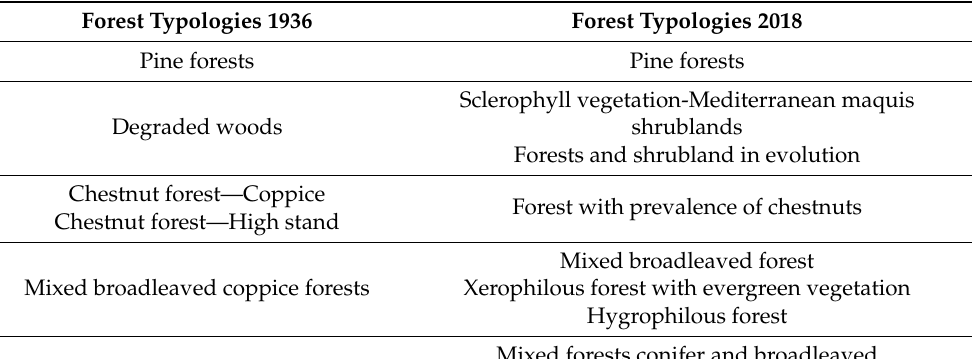
Table 1. Comparison of the forest typologies of the Forest Map of the Kingdom of Italy of 1936 and of the Land Use Map of 2018 of Liguria